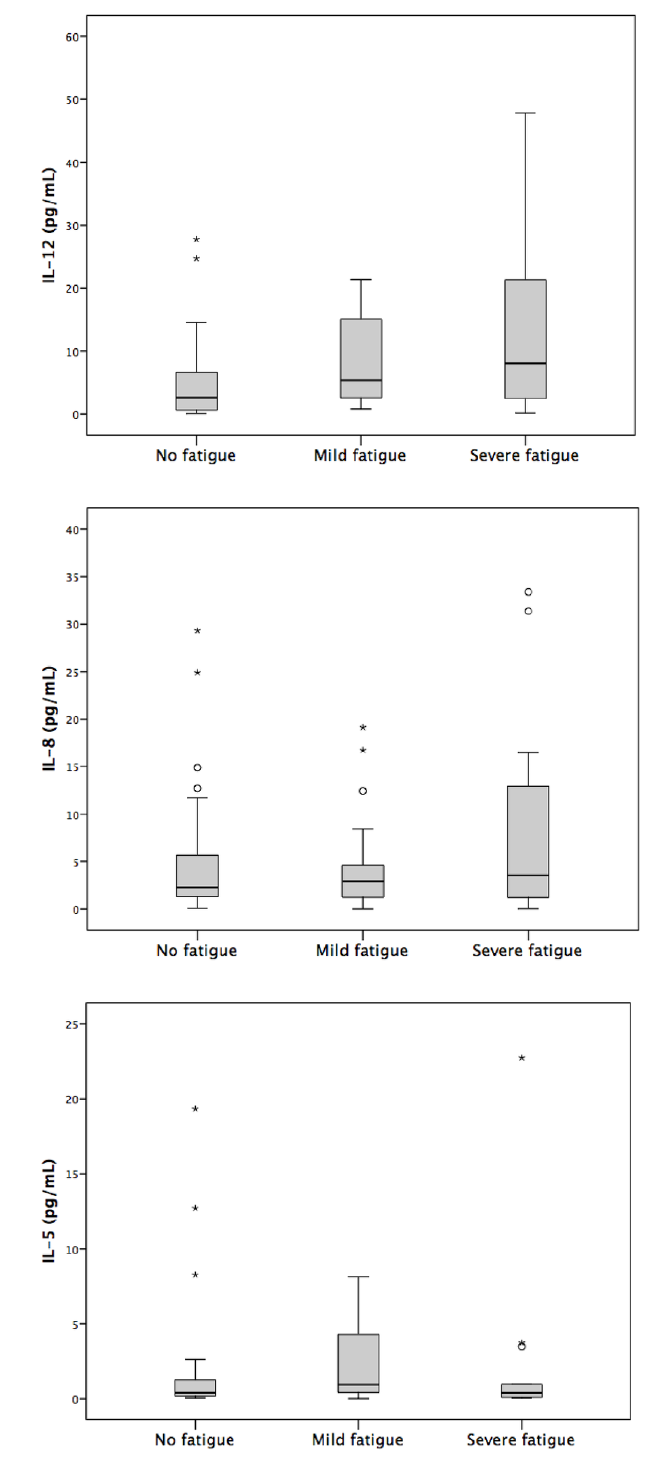
Fig 1. IL levels (pg/mL) in fatigue and non fatigue patients.